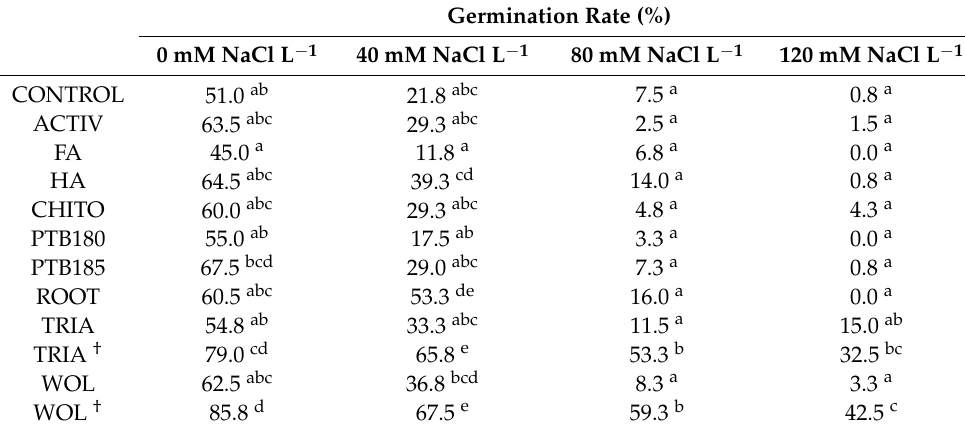
Table 5. Effect of biostimulants and salinity levels on the germination rate of baby leaf lettuce seeds under conventional management.